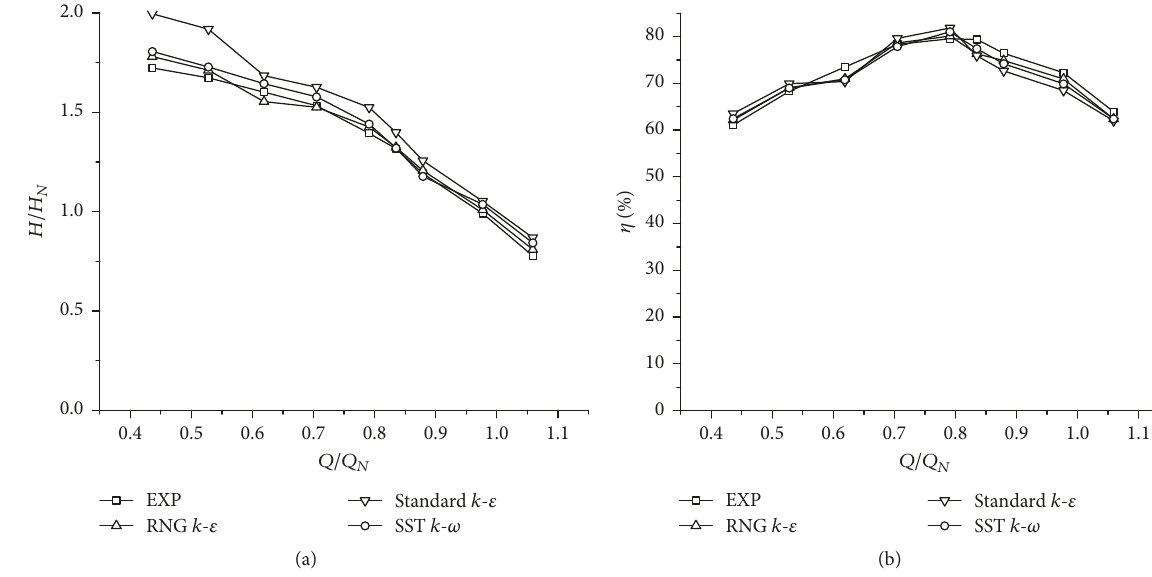
Figure 5: Comparisons of H - Q curve and 𝜂 - Q curve in numerical results and experimental results.